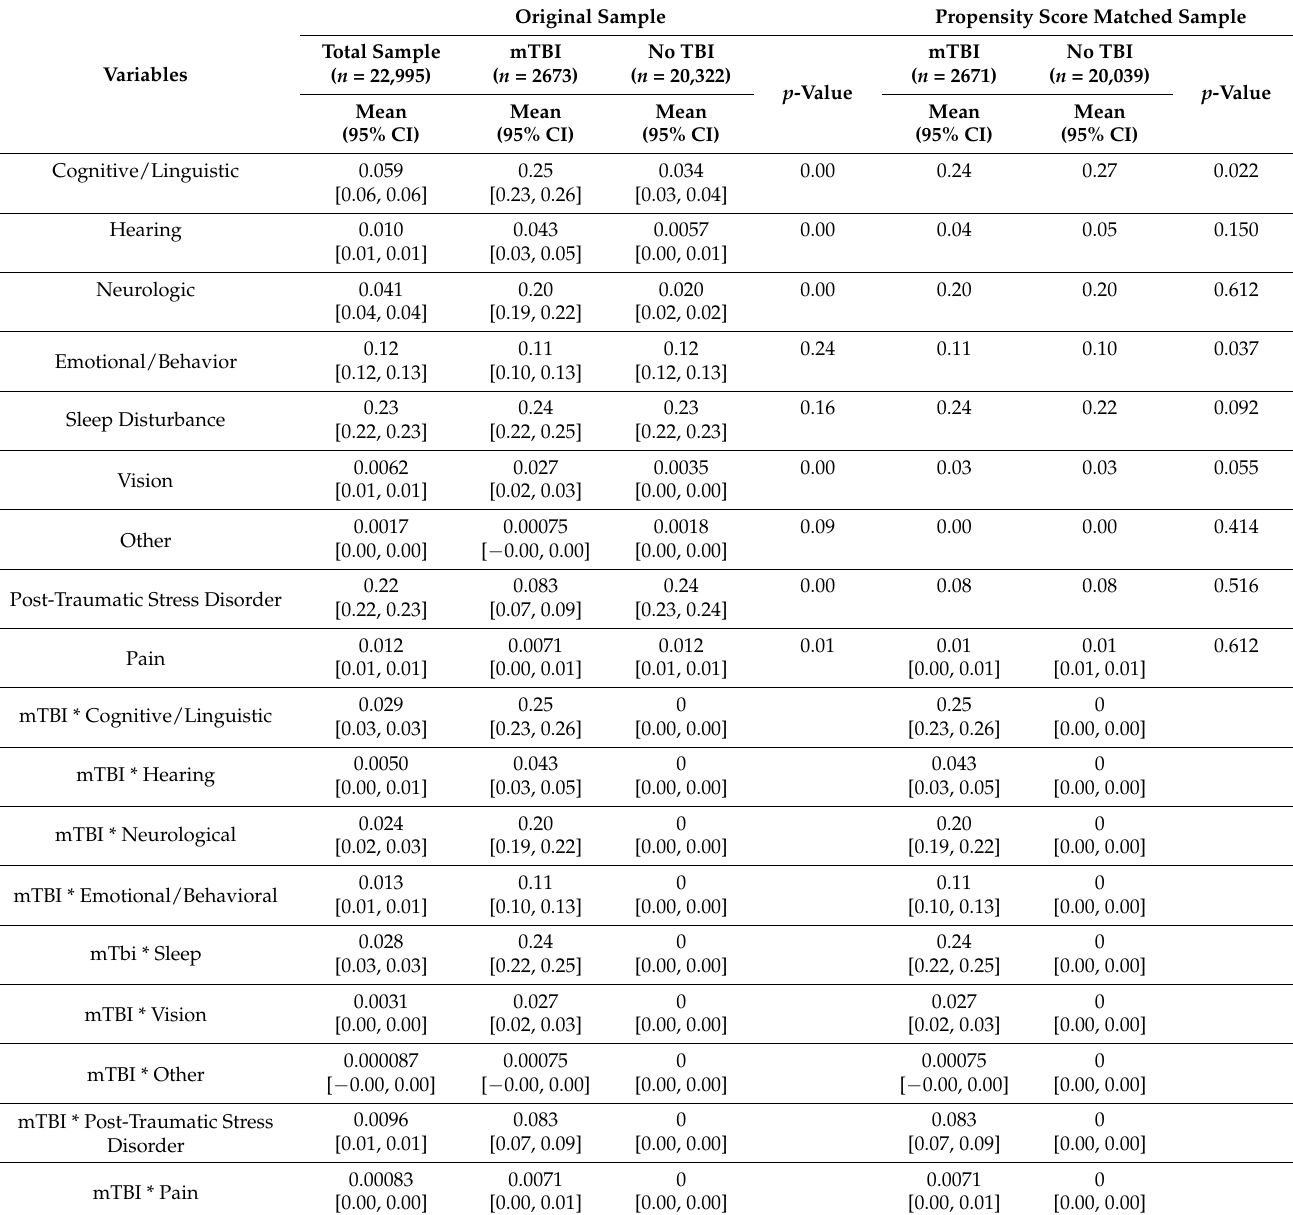
Table 2. Summary statistics of common symptoms # of mild traumatic brain injury, Military Health System data repository,